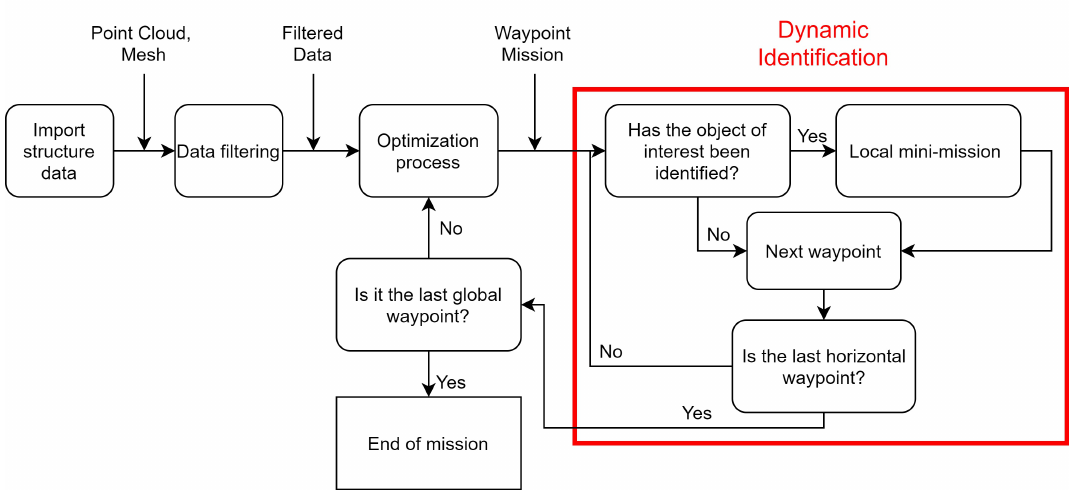
Figure 1. Framework